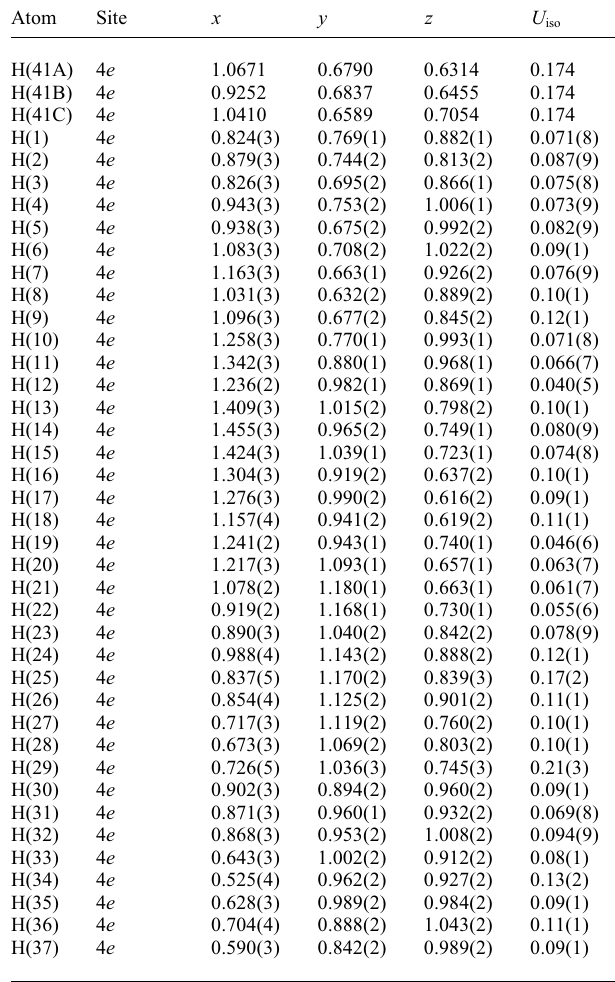
Table 2. Atomic coordinates and displacement parameters (in Å 2 )